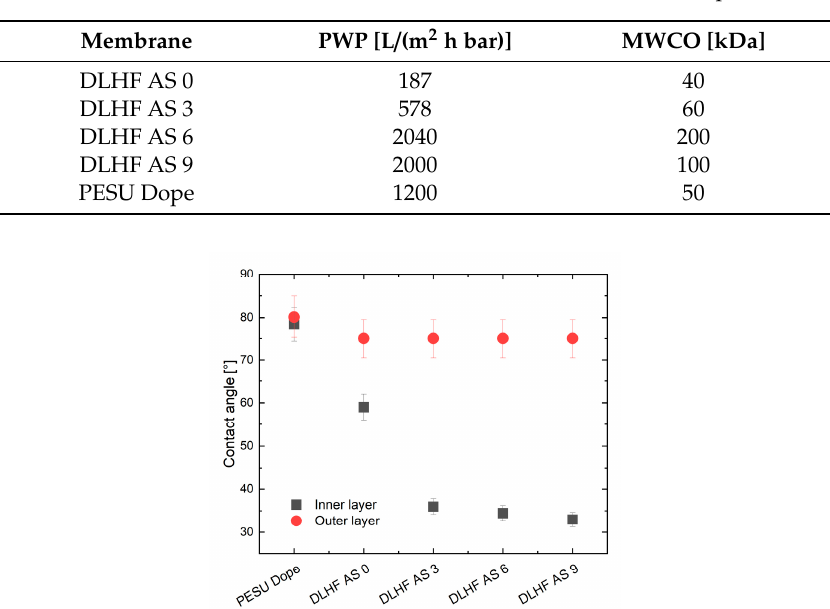
Table 5. PWP and MWCO of DLHF membranes and the PESU standard dope membrane.